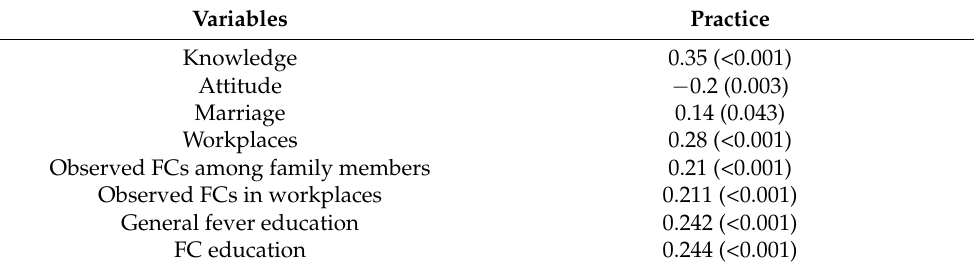
Table 4. Correlations between febrile convulsion practices and other variables ( n = 216). Variables